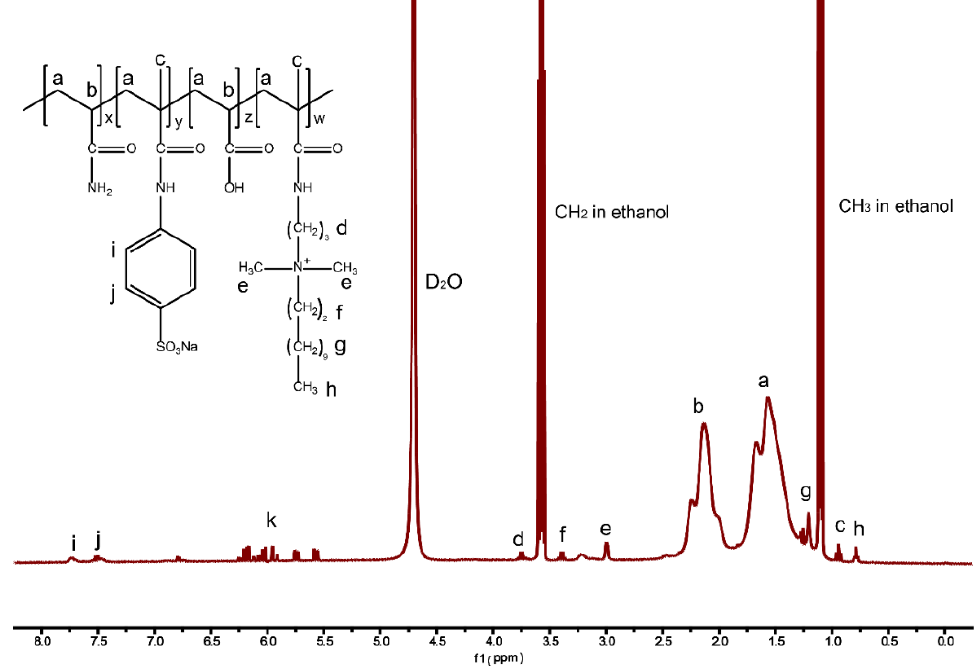
Figure 2. The 1 H NMR spectrum results for HELV.